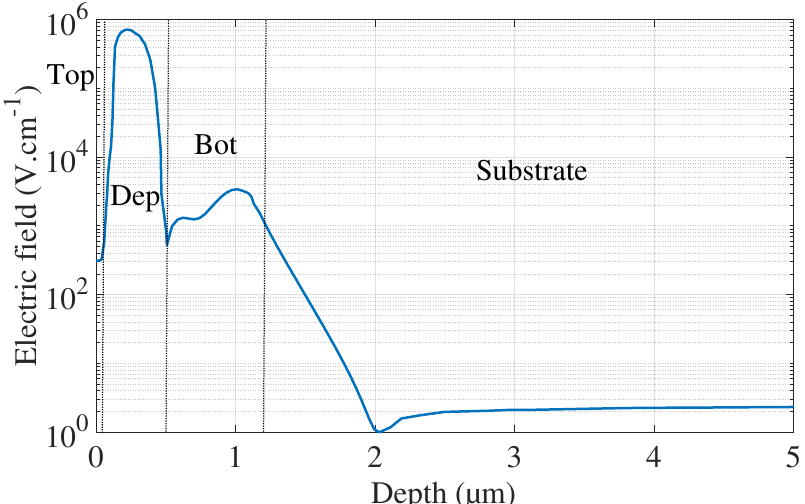
Figure 6. Electric field profile obtained with TCAD simulation based on doping profile measurement for V Ex = 20% V Br . A logarithmic scale is used for the vertical axis.